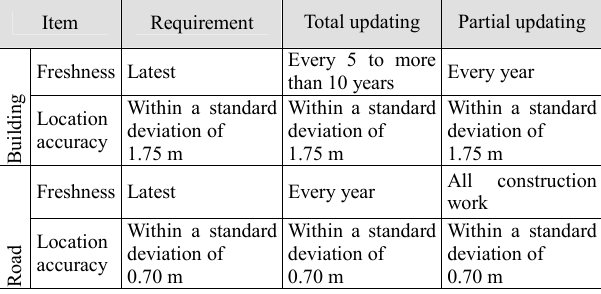
Table 5. Evaluation